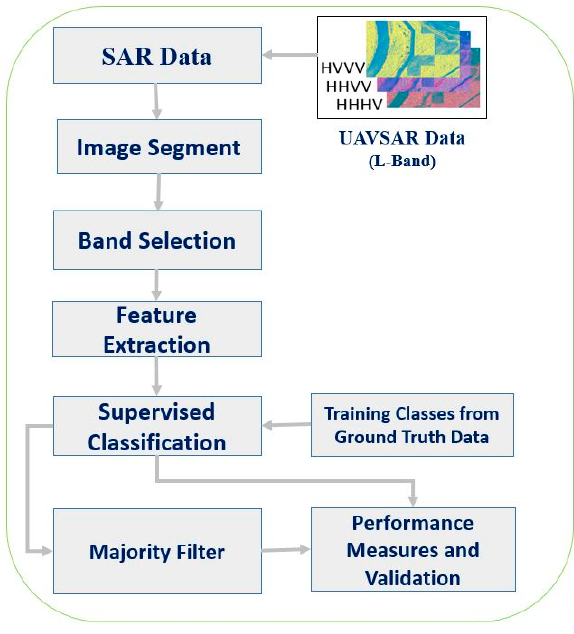
Figure 1. Processing steps for slide detection on levee.